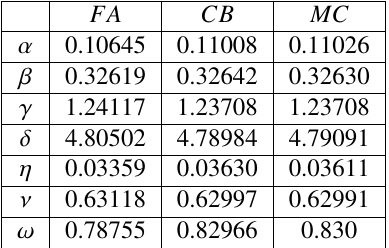
Table 2. Critical exponents for O (1)-symmetric ϕ 4 field theory in 3 d , calculated using self-similar factor approximants (FA), conformal bootstrap conjecture (CB), and Monte Carlo simulations (MC)